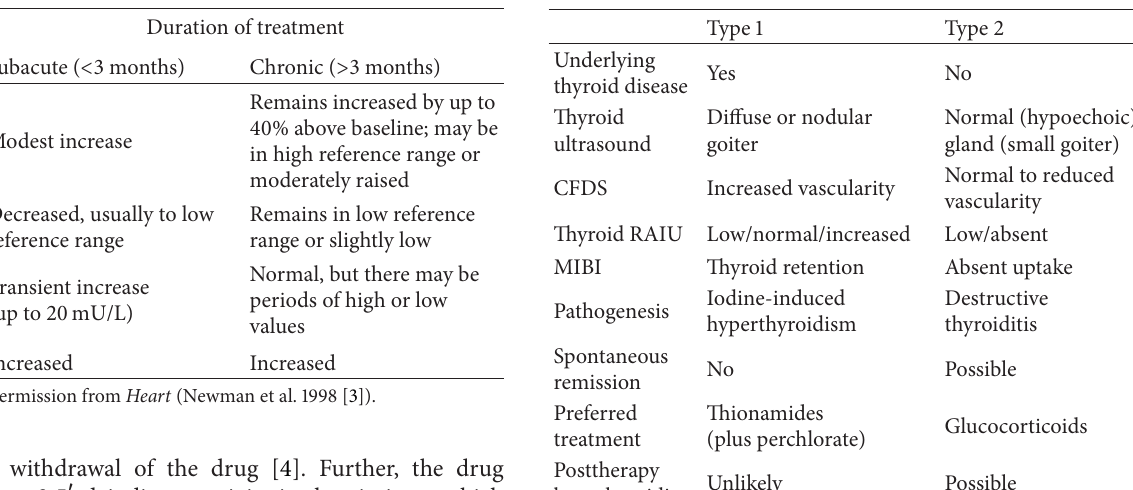
Table 2: ∗ Clinical and pathologic features distinguishing type 1